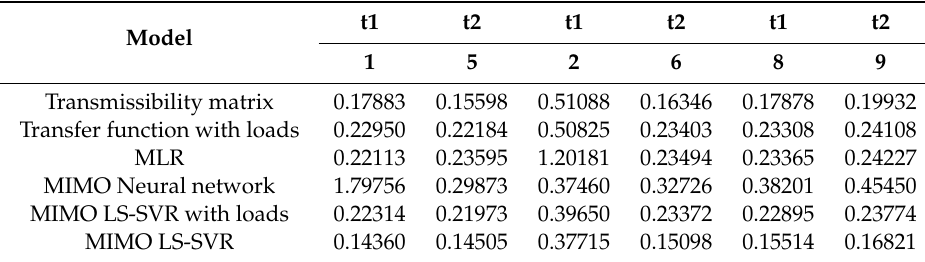
Table 3. Mean absolute percentage error (MAPE) of the predicted multi-point vibration response for different models.